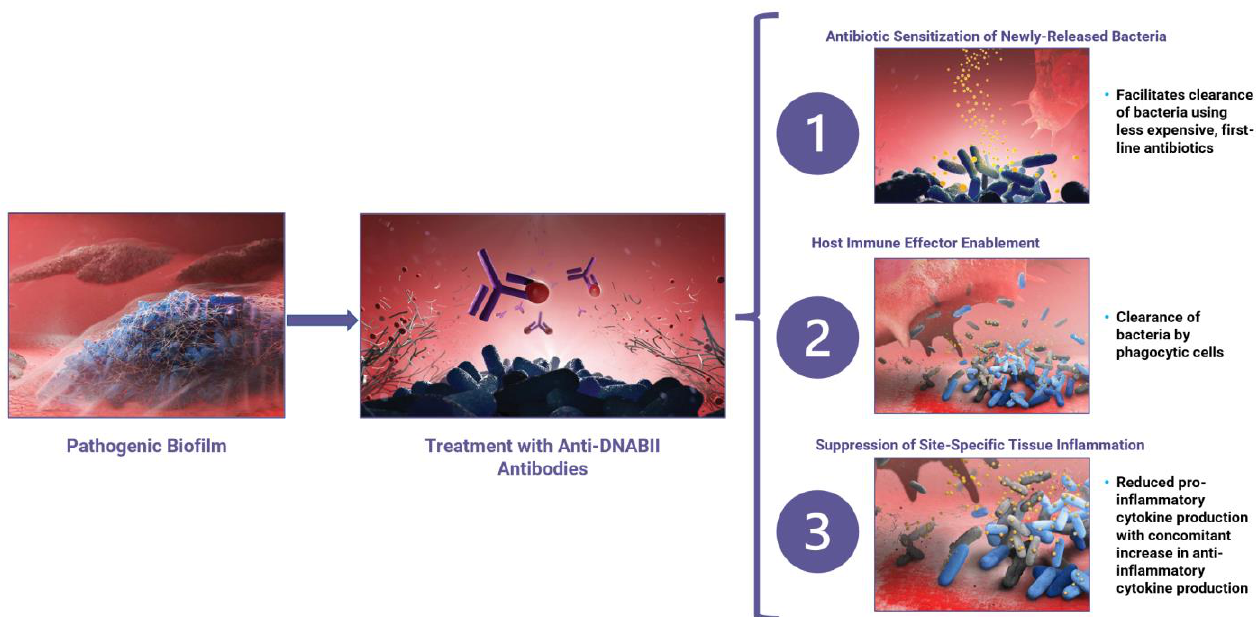
Figure 3. Treatment of an established pathogenic biofilm (left panel) with anti-DNABII antibodies (purple; middle panel) leads to the capture and removal of available key linchpin DNABII proteins (red; middle panel) from the extracellular matrix, resulting in rapid biofilm collapse. This rapid col- lapse leads to three distinct modes of action (right panel): (1) sensitization of bacteria to antibiotics, (2) host immune system enablement, and (3) suppression of site-specific tissue inflammation. (2) host immune system enablement, and (3) suppression of site-specific tissue